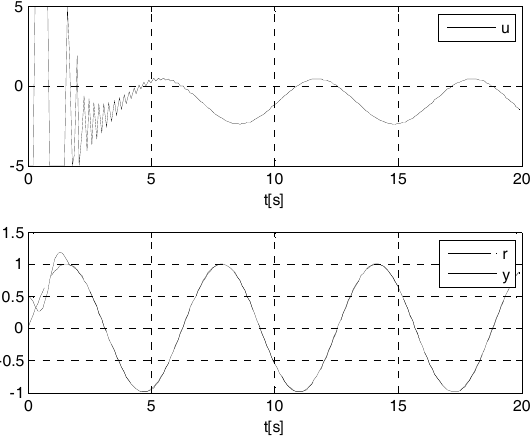
Figure A3. Time histories of u , r , y with the model predictive control (MPC) controller.